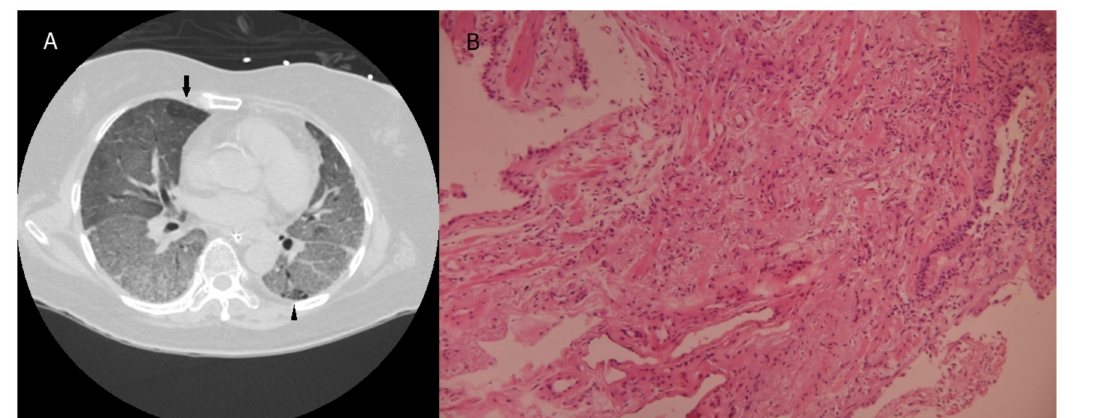
Figure 2. ( A ) The transverse unenhanced chest CT image showed diffuse ground glass opacities and reticulations in bilateral lungs. There were foci of air trapping in the peripheral right upper lung (arrow) and subpleural honeycombing in the left lower lung (arrowhead). ( B ) The lung parenchyma showed fibrosis (hematoxylin and eosin stain, 100 ×